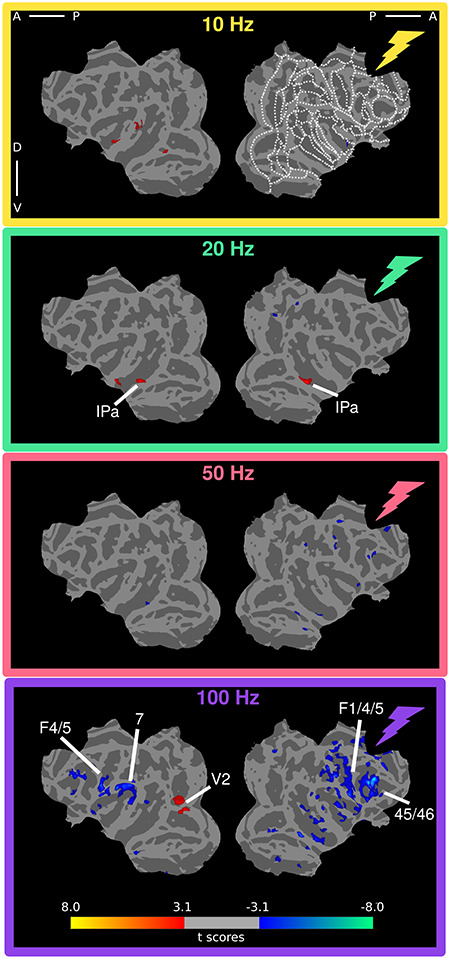
fMRI response to VTA stimulation across frequencies in anesthetized monkeys. T-score maps of the stimulation frequency versus baseline (uncorrected level, P < 0.001; cluster correction, 20) overlaid onto cortical flatmaps in the D99 template space (see Materials and Methods). Regions showing significant activation are indicated on the maps. For a complete overview of ROIs and ROI abbreviations in D99 space see Supplementary Material S5.